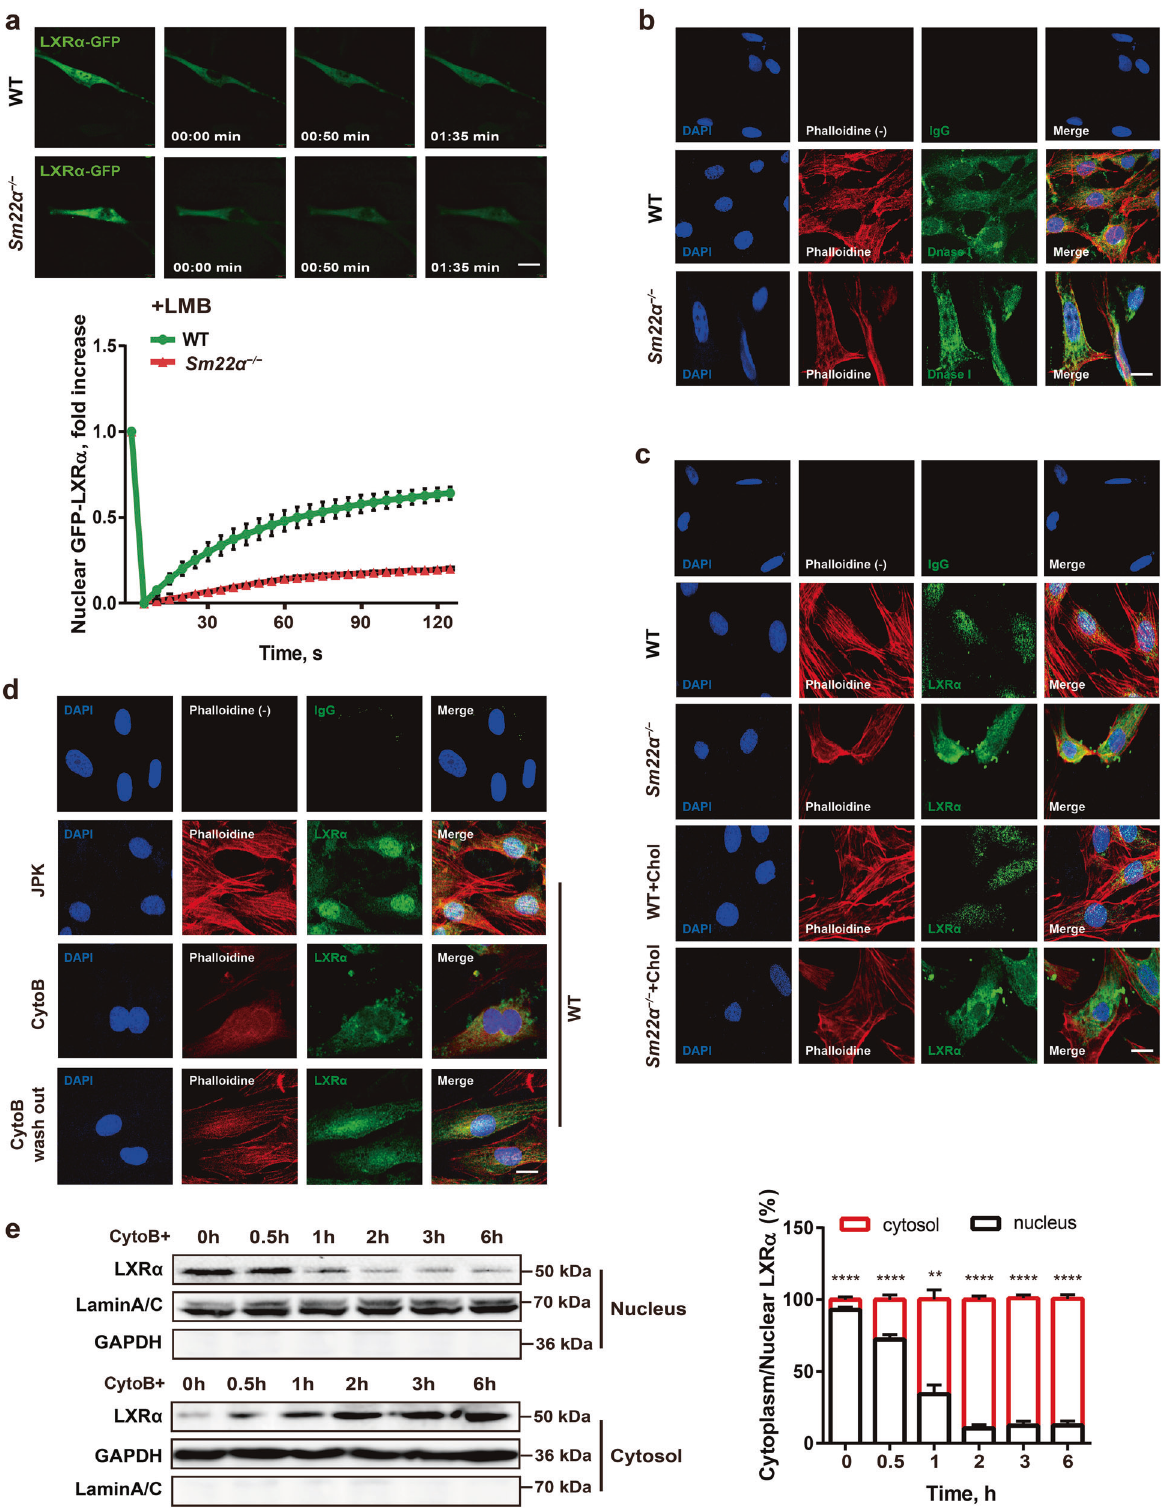
Fig. 4 Nuclear import of LXR α is regulated by actin dynamics. a Fluorescence recovery after photobleaching (FRAP) studies with LXR α -GFP to measure nuclear import. Cells were pretreated with LMB. Decreased accumulation of nuclear fl uorescence indicates a lower rate of nuclear import of LXR α -GFP in Sm22 α − / − VSMCs relative to WT controls ( n = 25). b Representative images of F-actin (phalloidin, red) and G-actin (DnaseI, green) in WT and Sm22 α − / − VSMCs. Scale bar, 10 μ m. c , d Representative images for F-actin (phalloidin, red) and LXR α (green) in WT and Sm22 α − / − VSMCs with cholesterol loading or not ( c ) and in WT VSMCs treated with JPK, CytoB and after CytoB washout ( d ). Scale bars, 10 µm. e Western blot analysis of cytoplasmic and nuclear LXR α in WT VSMCs treated with CytoB at different time points ( n = 6). Data and images represent at least three independent experiments. Statistical analyses, unpaired t -test and Kruskal – Wallis rank sum test. ** p < 0.01; *** p < 0.001; **** p < 0.0001. Cell Death and Disease (2021)